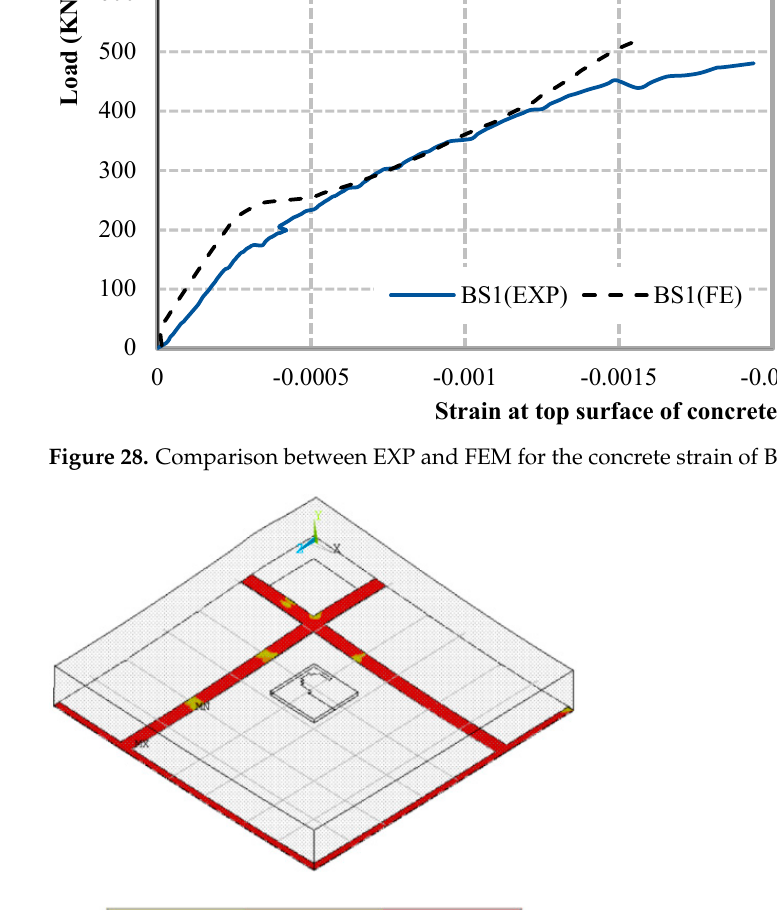
Figure 29. Final stage of CFRP laminates debonding in BN slab model.